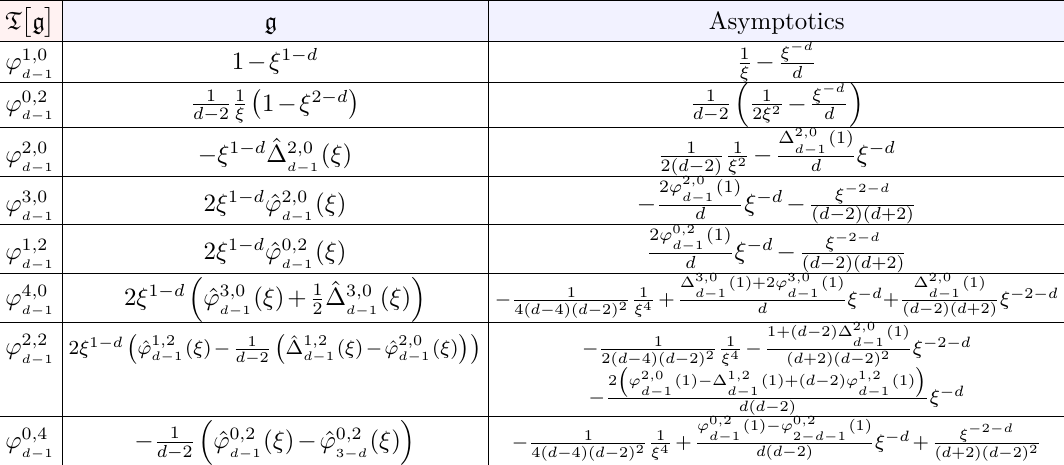
Table 3 . The functions appearing in the gradient expansion of the Markovian ϕ order in gradients, given in the form of an integral transform defined in eq. (D.17). We also present the leading asymptotic behaviour of the functions which is used for computing boundary